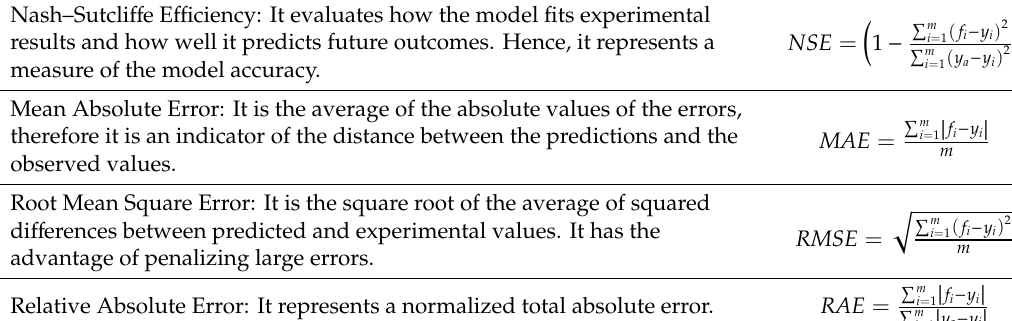
Table 2. Criteria for evaluating the accuracy of the